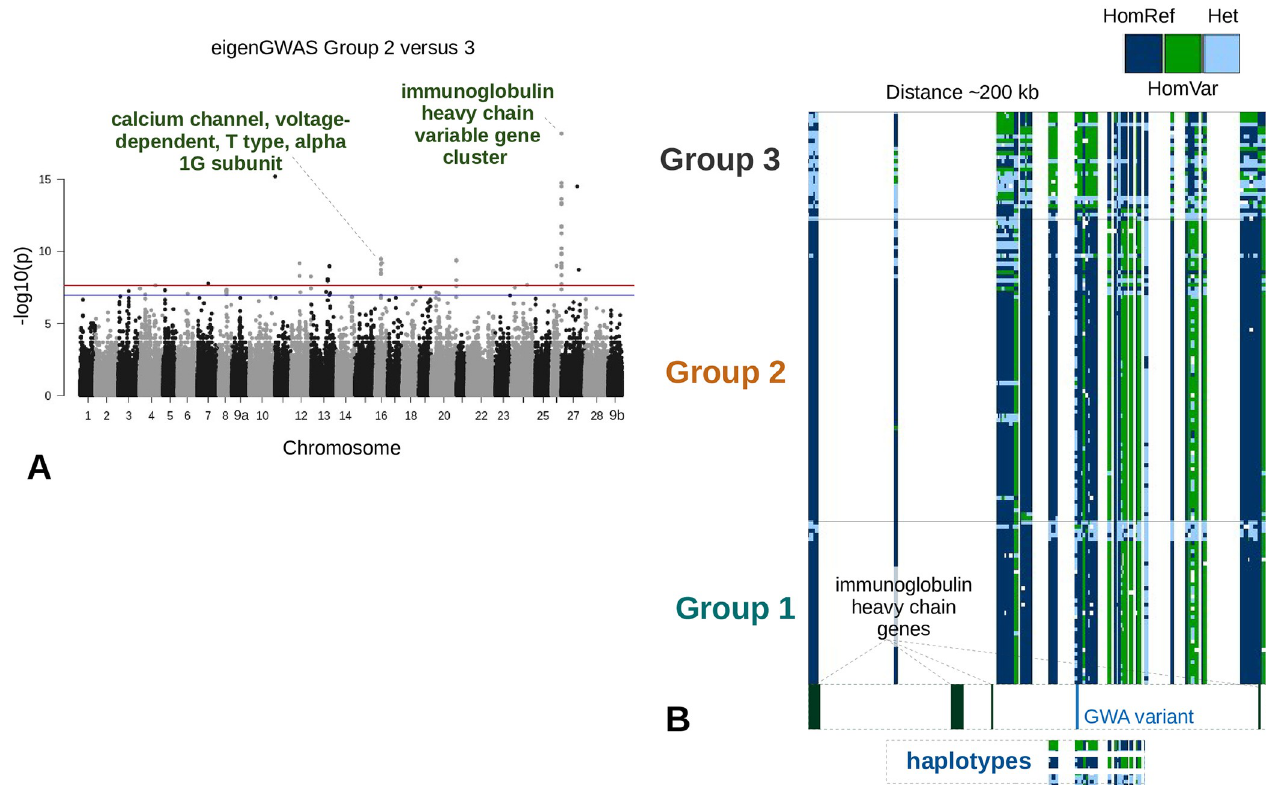
Fig 4. Genomic regions associated with eigenvalues from DAPC groups 2 and 3. A) A Manhattan plot of an eigenGWA using the LD1 values from the DAPC analysis after accounting for the genomic inflation factor. Only the individuals from groups 2 and 3 were included in this analysis to specifically find genomic regions underlying clustering differences in DAPC 2 and 3. The horizontal blue line represents the Bonferroni correction at the 0.05 alpha level (variants interrogated = 450,868) and the red line at the 0.01 alpha level (0.01 was chosen as the level of significance for this study). Only peaks with at least 5 significant variants within 100 kbp of each other were considered. B) A screenshot from IGV showing genetic markers in LD (r 2 > = 0.3) with the variant with the lowest p-value from the eigenGWA (distance ~200 kb). The dark blue colour represents homozygous reference variants (HomRef), the green colour represents homozygous alternative variants (HomVar), and the light blue colour represents heterozygous variants (Het). Near the bottom of Fig 4B shows the location of the immunoglobulin heavy chain genes and the variant with the lowest p-value are shown. Below that are examples of the haplotypes seen in the data (see Fig 4B legend: dark blue, homozygous for the reference allele; green, homozygous with the alternative allele; light blue, heterozygous). These example data are shown to illustrate that this region is often homozygous for all the alleles in this block.